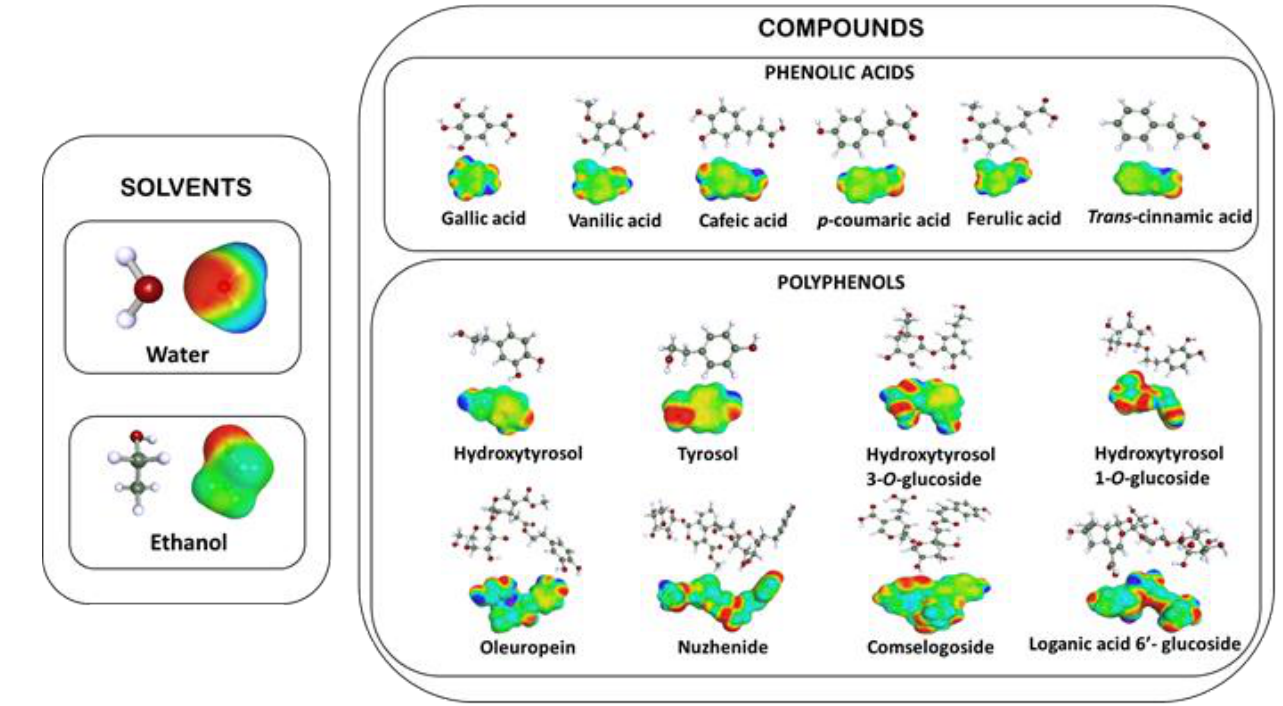
Figure 2. Molecular structures and σ -surfaces of the solvents and investigated solutes.